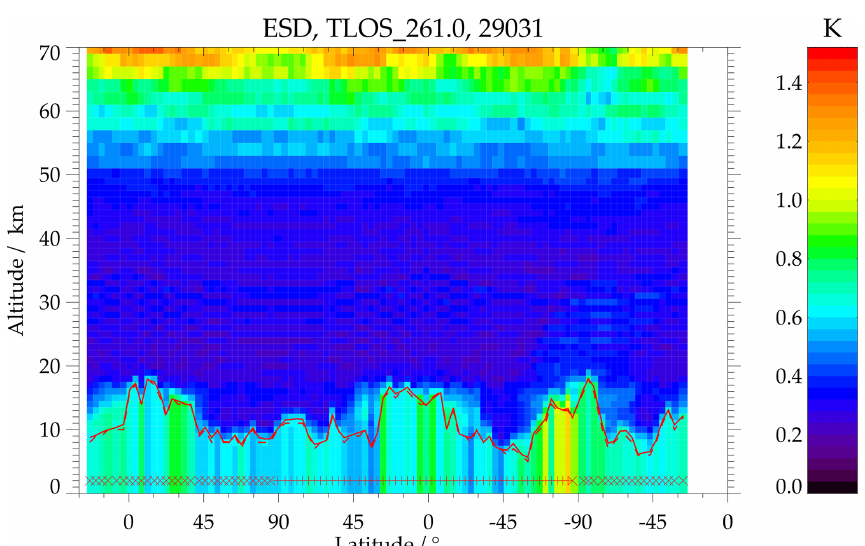
Figure 3. The noise component of temperature error in Kelvin for sample orbit 29031 as a function of latitude and altitude. The red line is the lower edge of the instrumental field of view at the lowermost tangent altitude used. Temperatures retrieved below this altitude are solely determined by the retrieval constraint. The symbols just above the latitude axis indicate the position of the measurement and give the illumination conditions (cross: night; plus: